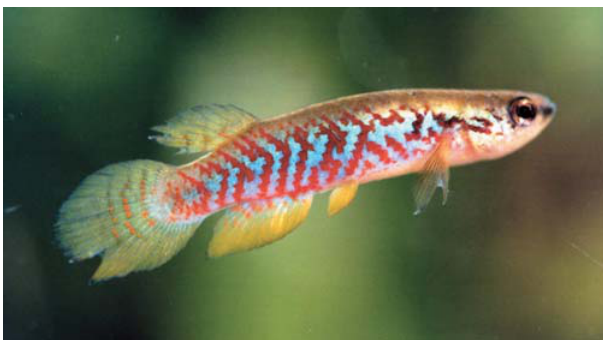
Fig. 10. Rivulus scalaris , UFRJ 5968, male, holotype, 26.8 mm SL (one day after collection); Brazil: Mato Grosso do Sul: Costa Rica. Photo by W. J. E. M.